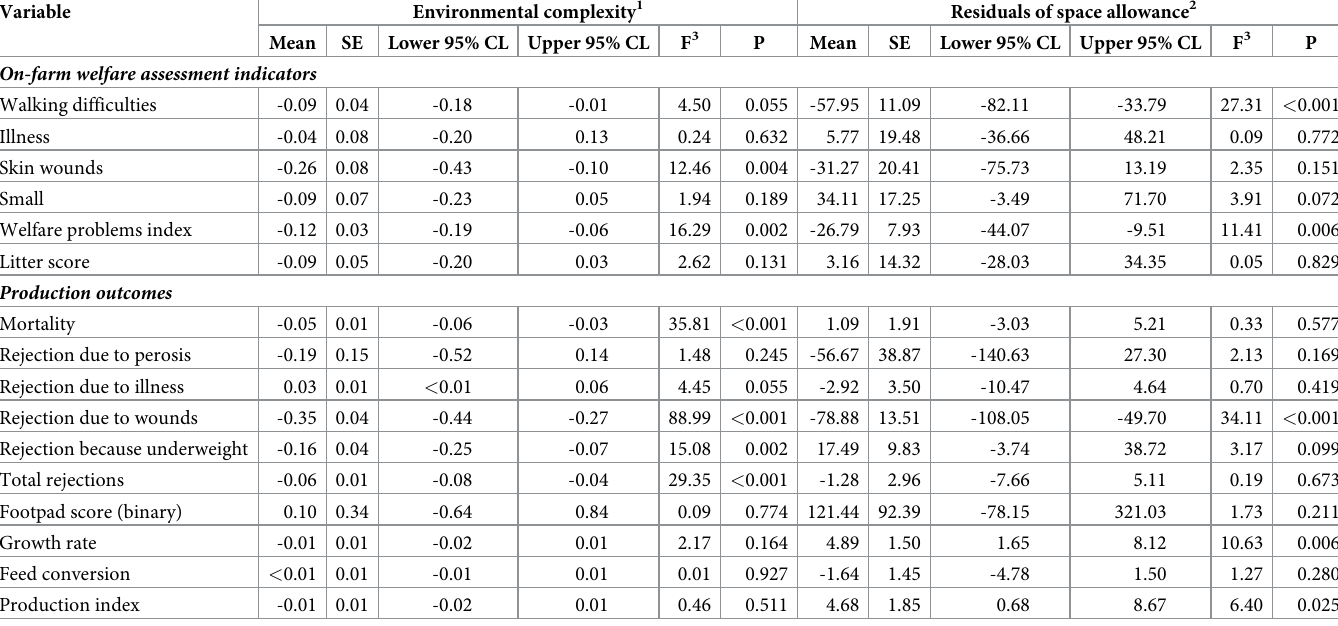
Table 4. Regression coefficient estimates for associations of environmental complexity and space allowance with welfare problems detected by transect sampling, and production outcomes.